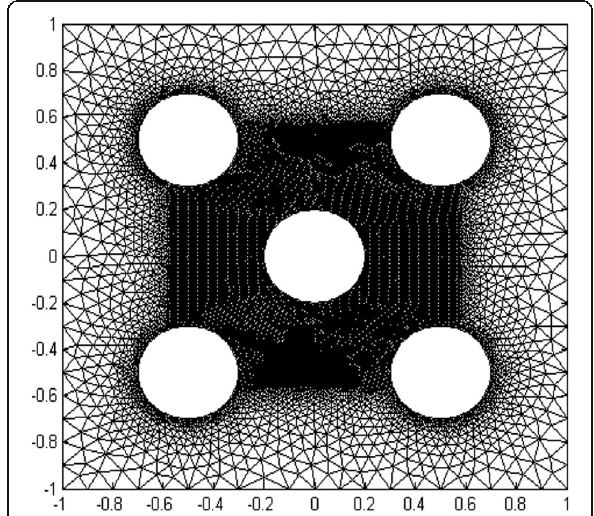
Fig. 8 Smoothed grids for